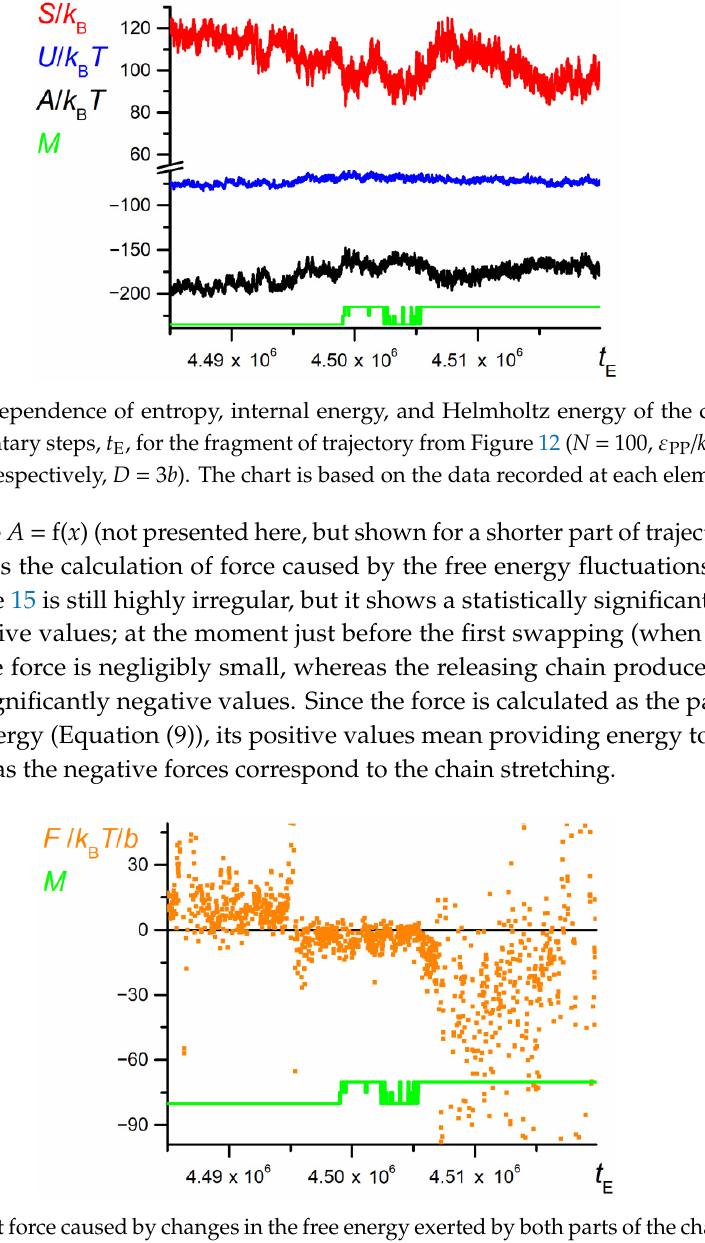
Figure 15. The net force caused by changes in the free energy exerted by both parts of the chain ( N = 100, ε PP / k B T = − 1 and 0 for P1 and P2, respectively, D = 3 b ). The chart is based on the data recorded at each elementary step.